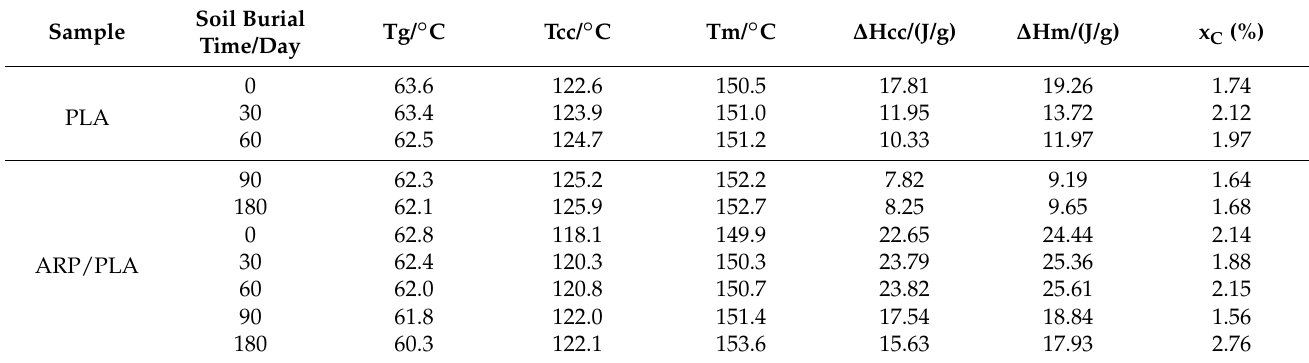
Table 2. DSC thermal information for different